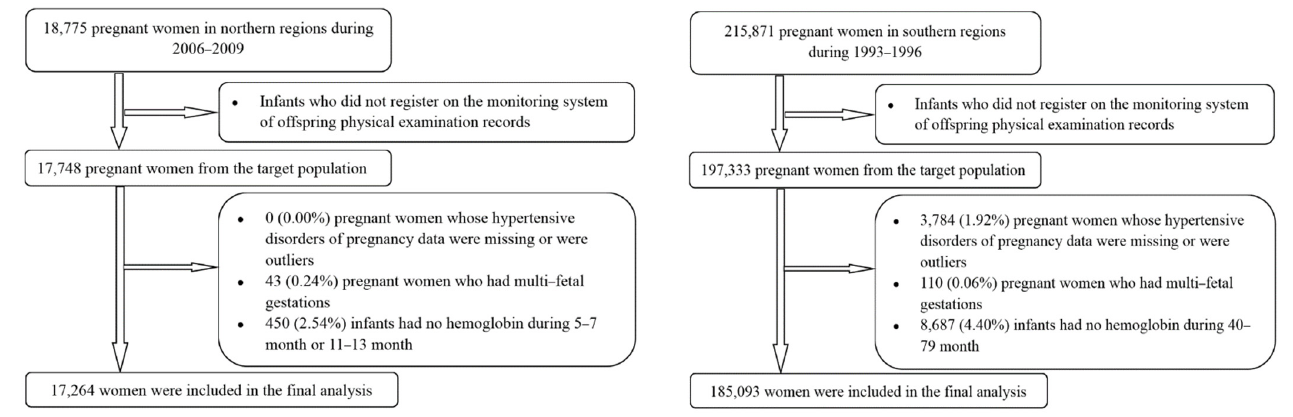
Figure 1. Flowchart of participants in cohort 1 ( left ) and cohort 2 ( right ).